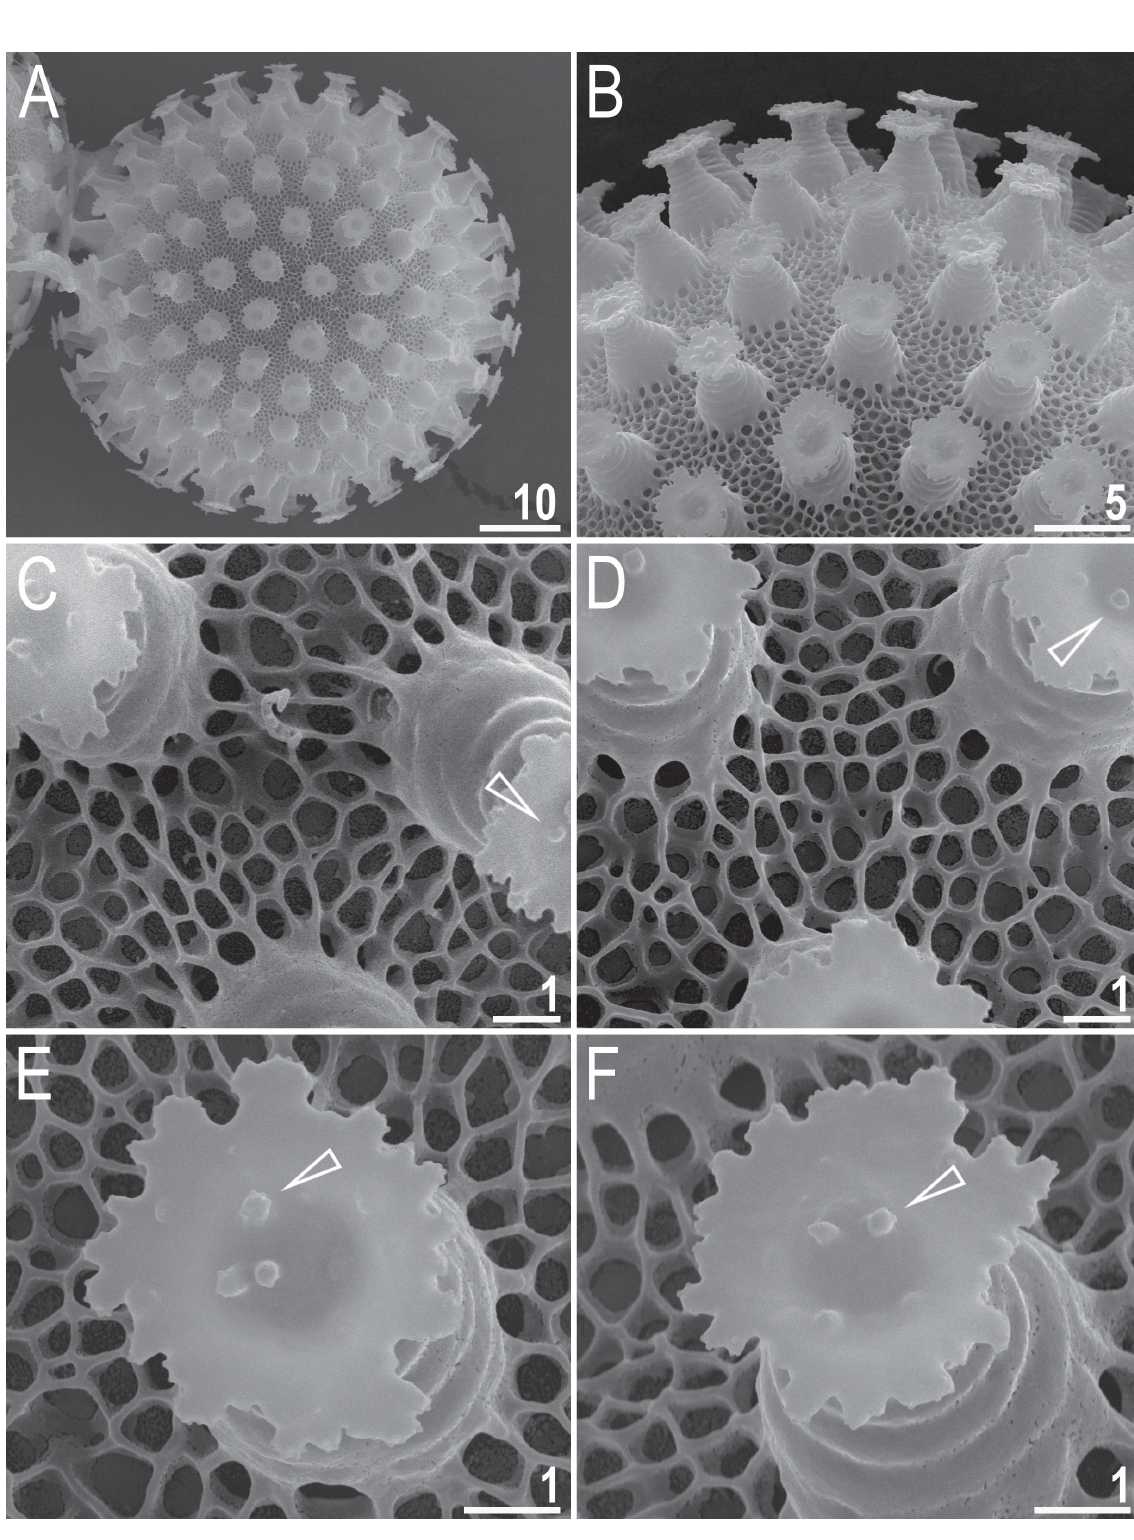
Fig. 7. Macrobiotus canaricus sp. nov., egg chorion morphology seen under SEM. A . Entire egg. B . Close up of the egg surface and processes. C–D . Details of the egg surface. E–F . Details of the terminal discs. Arrowheads indicate granules in the centre of the terminal discs. Scale bars in